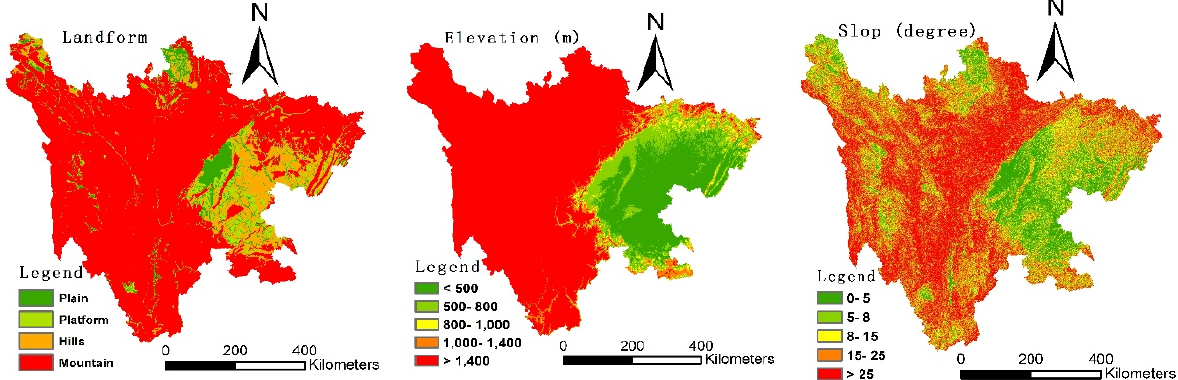
Figure 2. Elevation and slope in Sichuan Province.